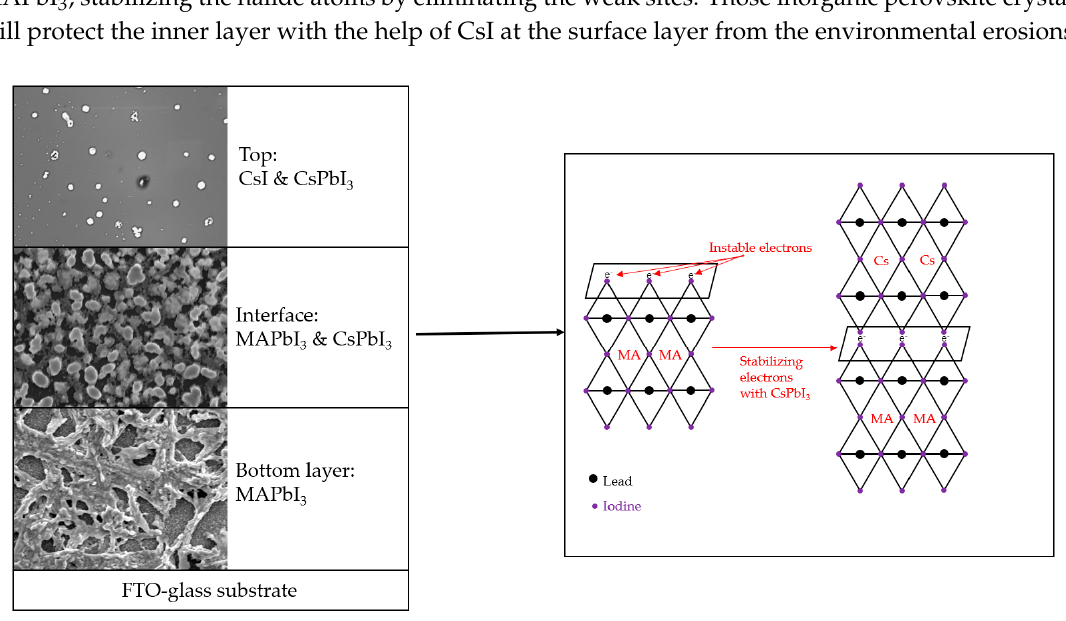
Figure 9. Layered structure of surface-passivated MAPbI 3 perovskite solar cell.